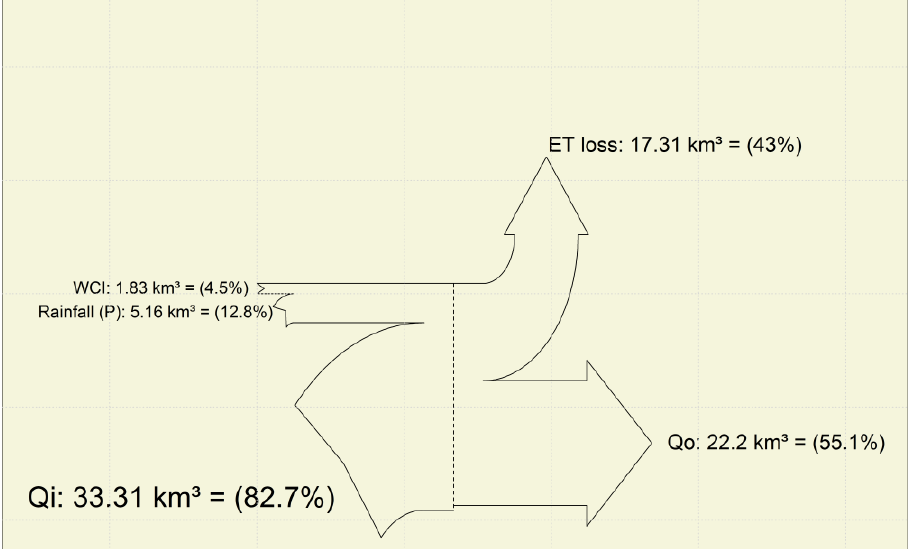
Figure 10: Sankey plot showing the annual average water fluxes of the water balance terms over the NID’s floodplain for the period 1980 - 2004. (With: Q i = river water inflow, calculated as the sum of discharge measured at the stations KeMacina and Douna, P = contribution (direct and indirect) of rainfall over the NID, ET = evapotranspiration loss over the NID calculated by PMO, WCI = return flow from irrigation to the NID’s water balance, Q o = river water outflow at the station of Diré, and % refer to the percent of the total annual flux).